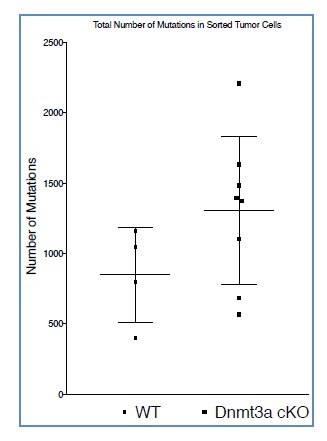
DOI:
http://dx.doi.org/10.7554/eLife.21697.036